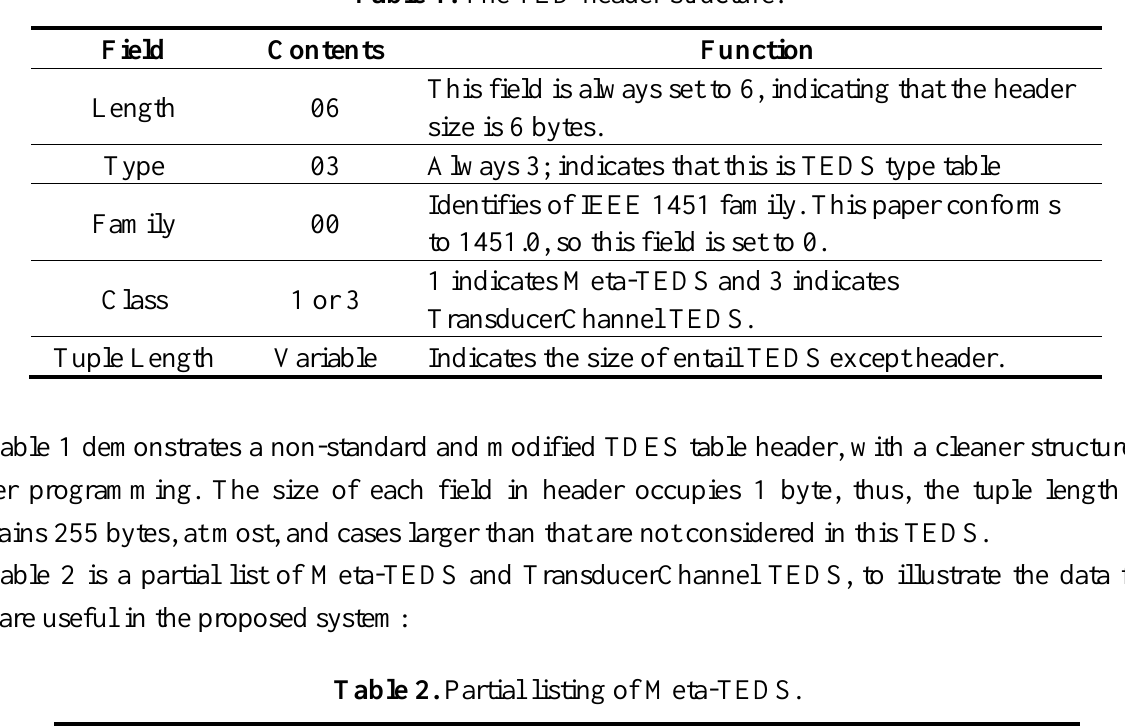
Table 1. The TED header structure.